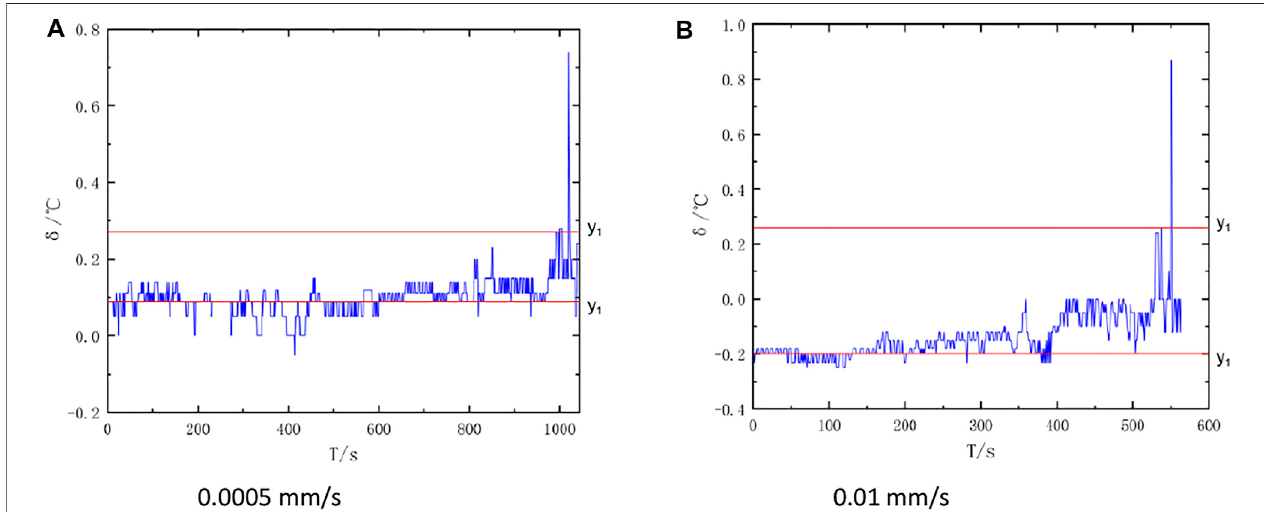
FIGURE 15 | Temperature difference between specimen and reference with loading time. (A) 0.0005 mm/s and (B) 0.01 mm/s.